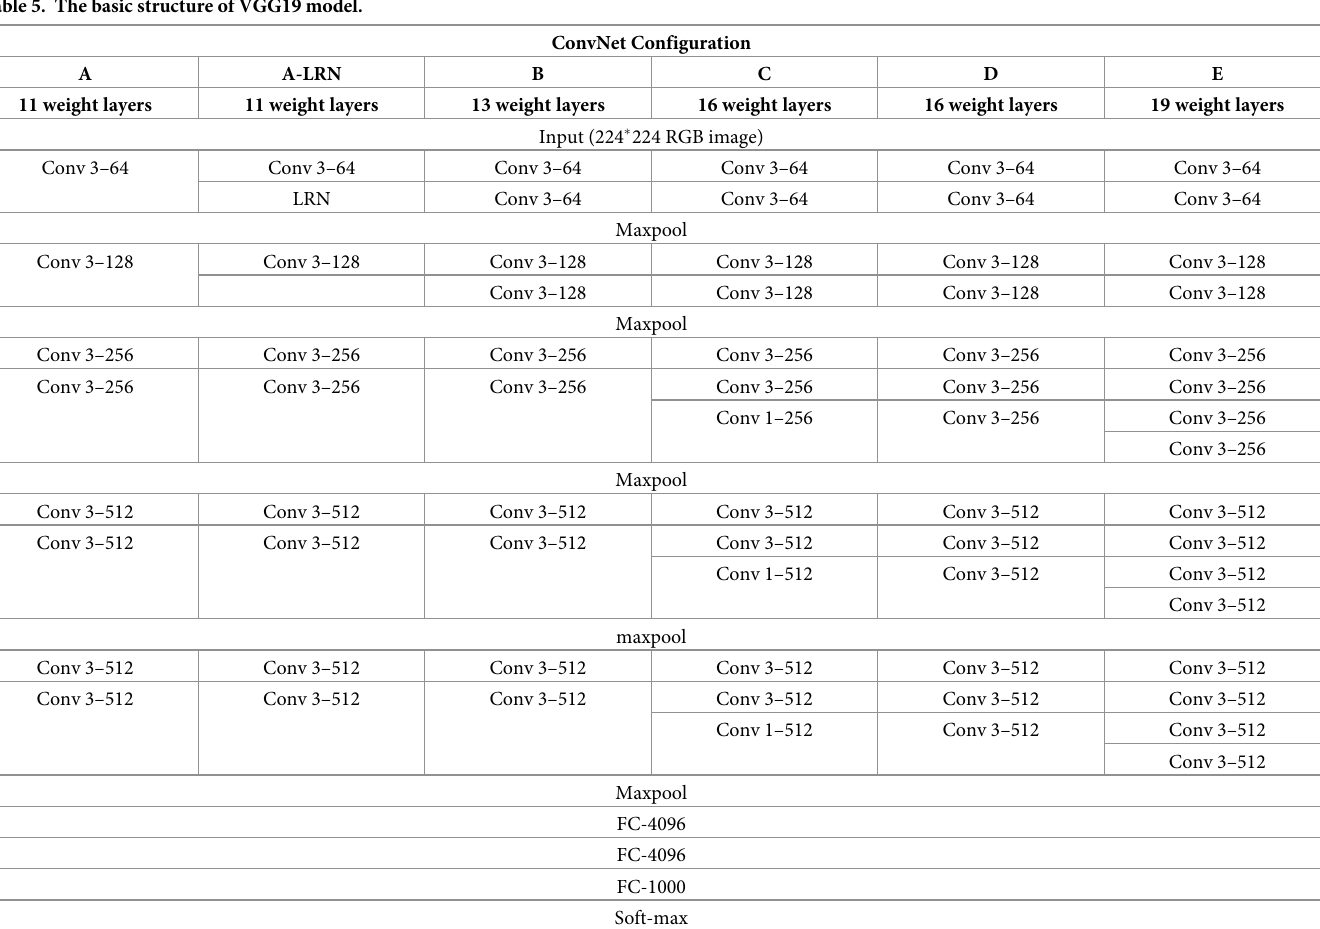
Table 5. The basic structure of VGG19 model.